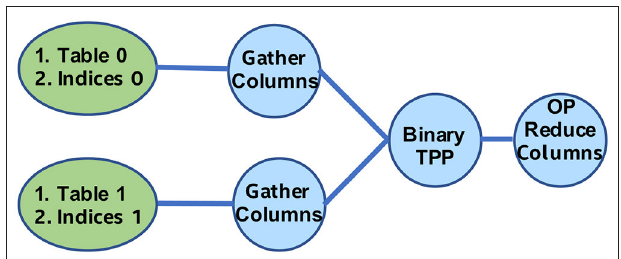
FIGURE 18 | Binary-Reduce aggregation kernel via